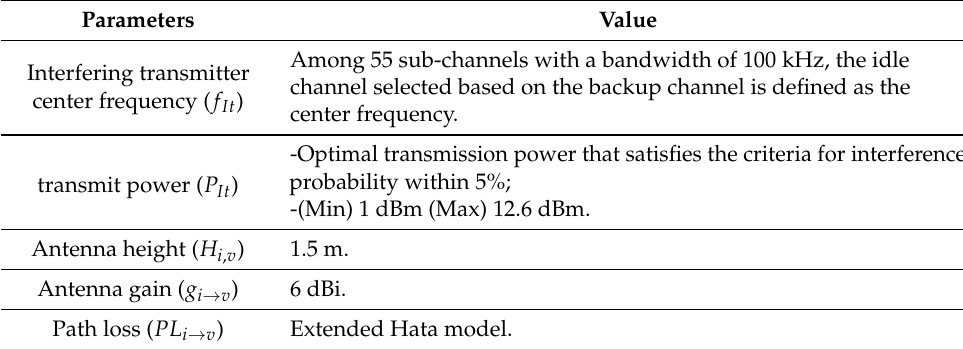
Figure 10. Inter cell interference scenario. Table 3. Interfering link parameters.